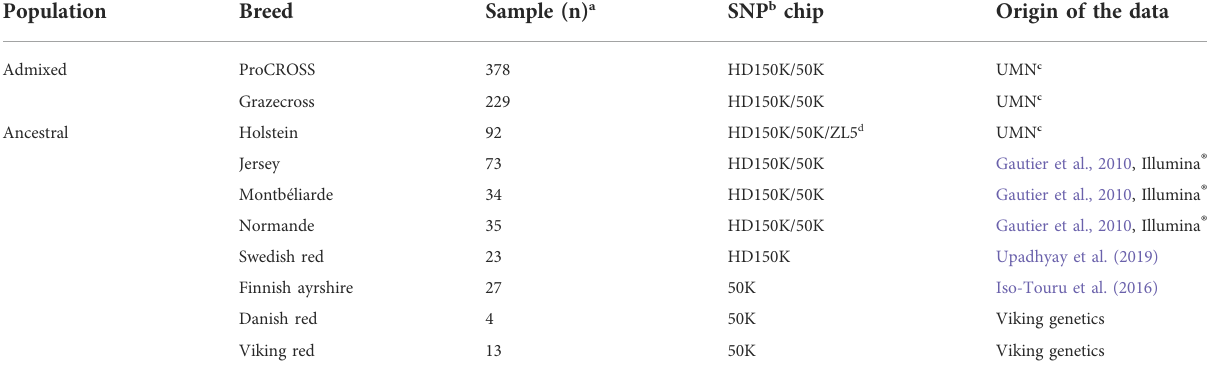
TABLE 1 Summary of cattle samples by population, respective breeds, number of animals and genotype source.